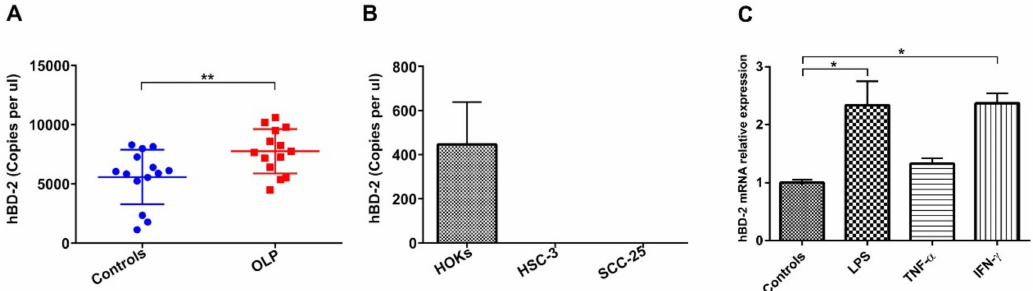
Figure 2. ( A ) Absolute quantification by droplet-digital (dd)PCR technology revealed a substantial upregulation of hBD-2 levels in OLP patients (average of ~8000 copies/ µ L) compared with normal individuals. ( B ) On the contrary, hBD-2 was robustly downregulated in tongue cancer cells (HSC-3 and SCC-25) compared with the highly expressed hBD-2 in normal human oral keratinocytes (HOKs). ( C ) Stimulating HOKs with bacterial lipopolysaccharide (LPS) and interferon- γ (IFN- γ ) for 8 h induced higher hBD-2 levels compared with tumor necrosis factor- α (TNF- α ) and non-stimulated control cells. Data are expressed as means ± SD; n = 14 for controls and OLP; * p ≤ 0.05, ** p ≤ 0.01. Mann–Whitney U test ( A ) and Kruskal–Wallis test followed by Dunn’s multiple comparisons correction test ( C ) were